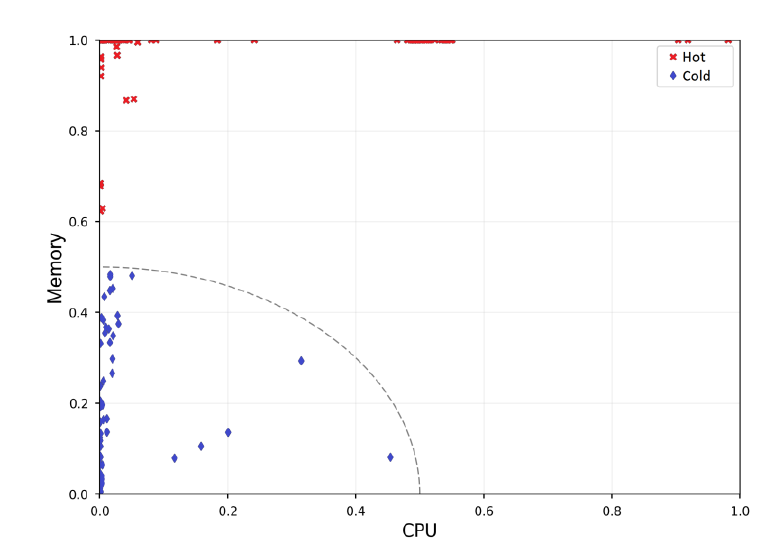
Fig. 2. Example of the VM classification in the JINR cloud. The X-axis shows the real CPU usage of the VM as a fraction of the total allocated CPU for the VM, the Y-axis shows the real memory usage by the VM as a fraction of the total allocated memory for the VM.